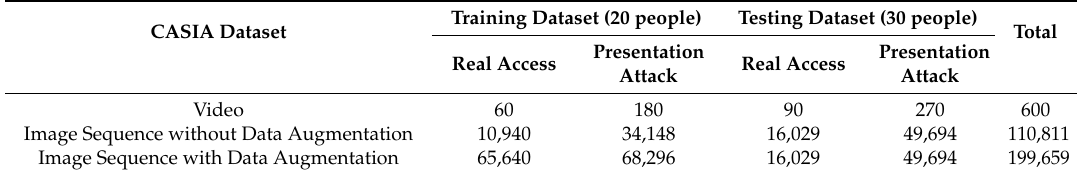
Table 4. Description of the CASIA dataset used in our study (unit: image sequences).